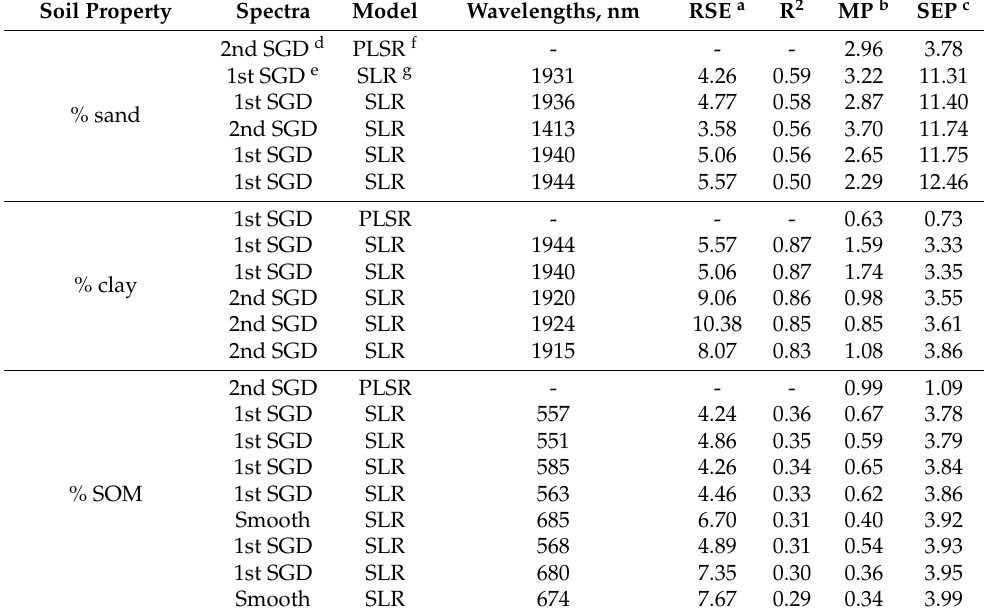
Table 5. The vis–NIR soil spectral bands which were capable of exhibiting the highest possible degree in terms of the precision and accuracy components, when predicting % sand, % clay and SOM content during ex situ